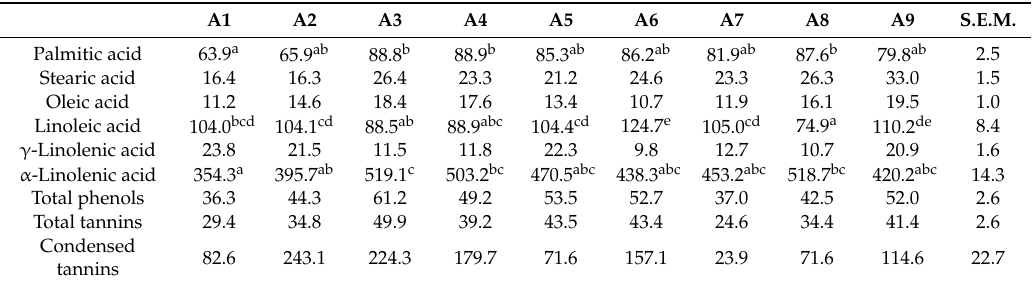
Table 3. Fatty acid (g / kg of total FA), total phenols (g / kg DM), total tannin (g / kg DM), and